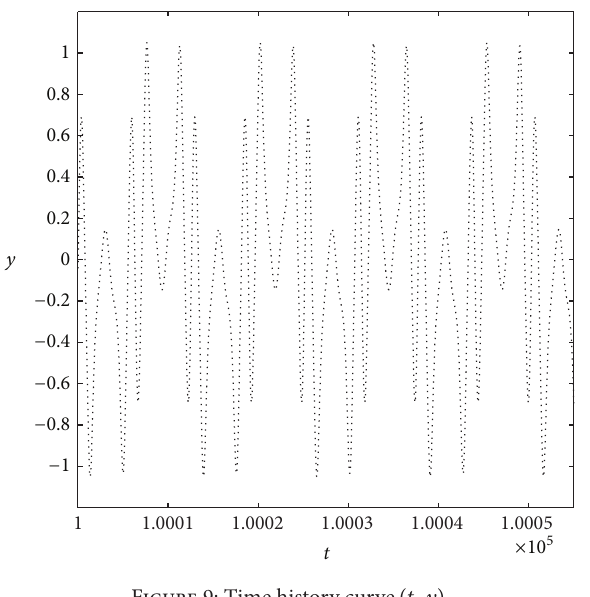
Figure 9: Time history curve (𝑡,𝑦) .